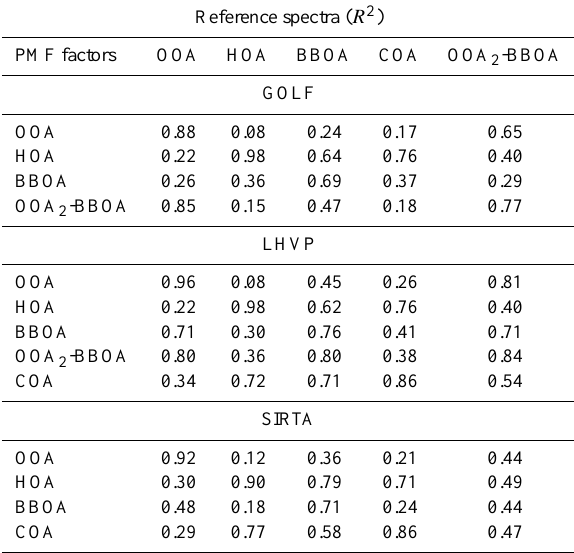
Table 1. Comparison between reference spectra and PMF factors. The COA reference spectra are calculated as the mean of all cook- ing emissions spectra measured by He et al. (2010); other reference spectra are provided by Ng et al. (2010) and by DeCarlo et al. (2010) for the OOA 2 -BBOA